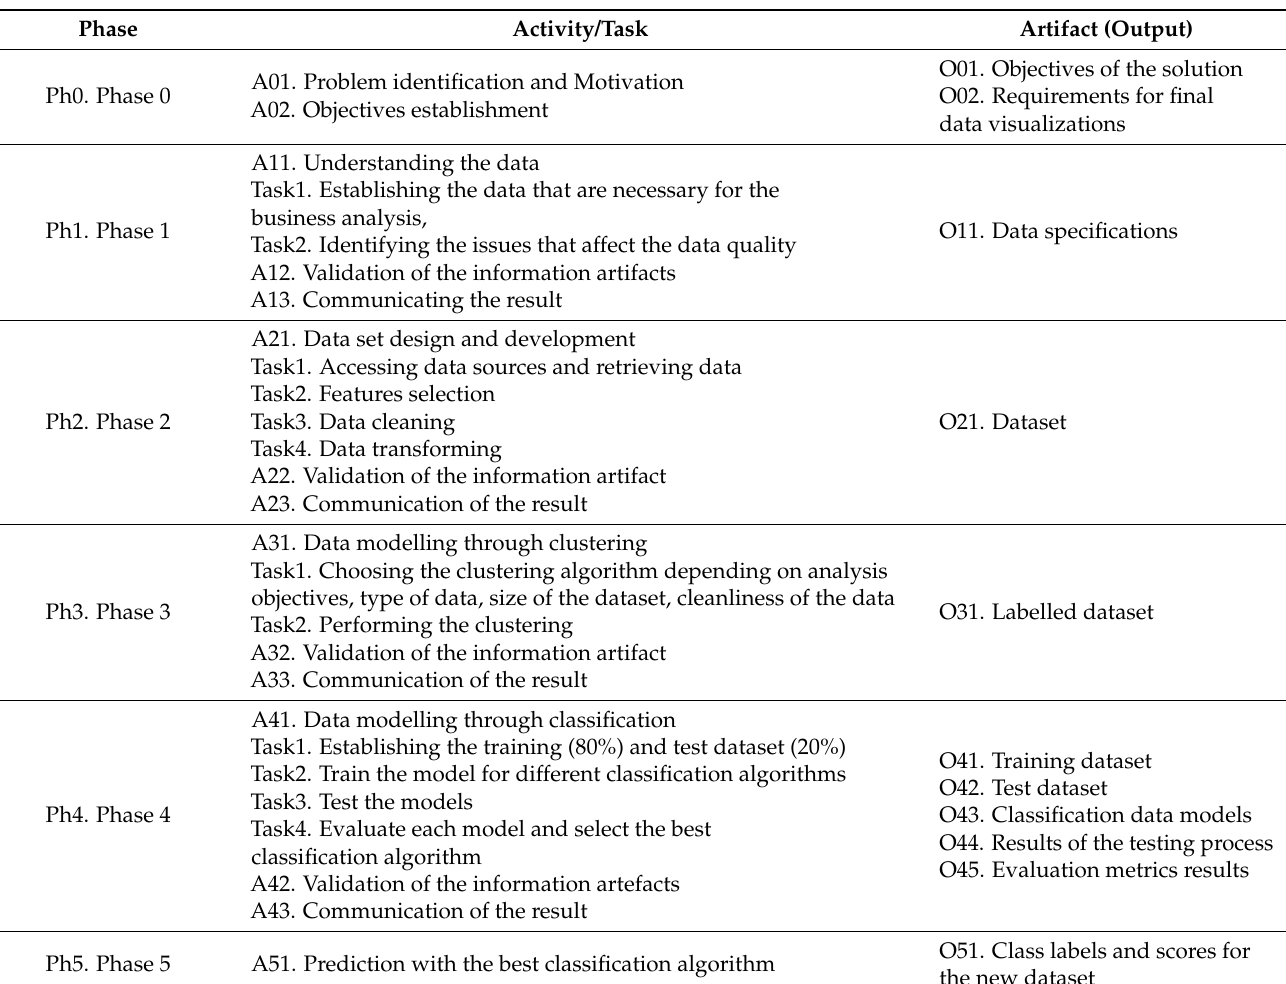
Table 2. DSR process. Using machine learning